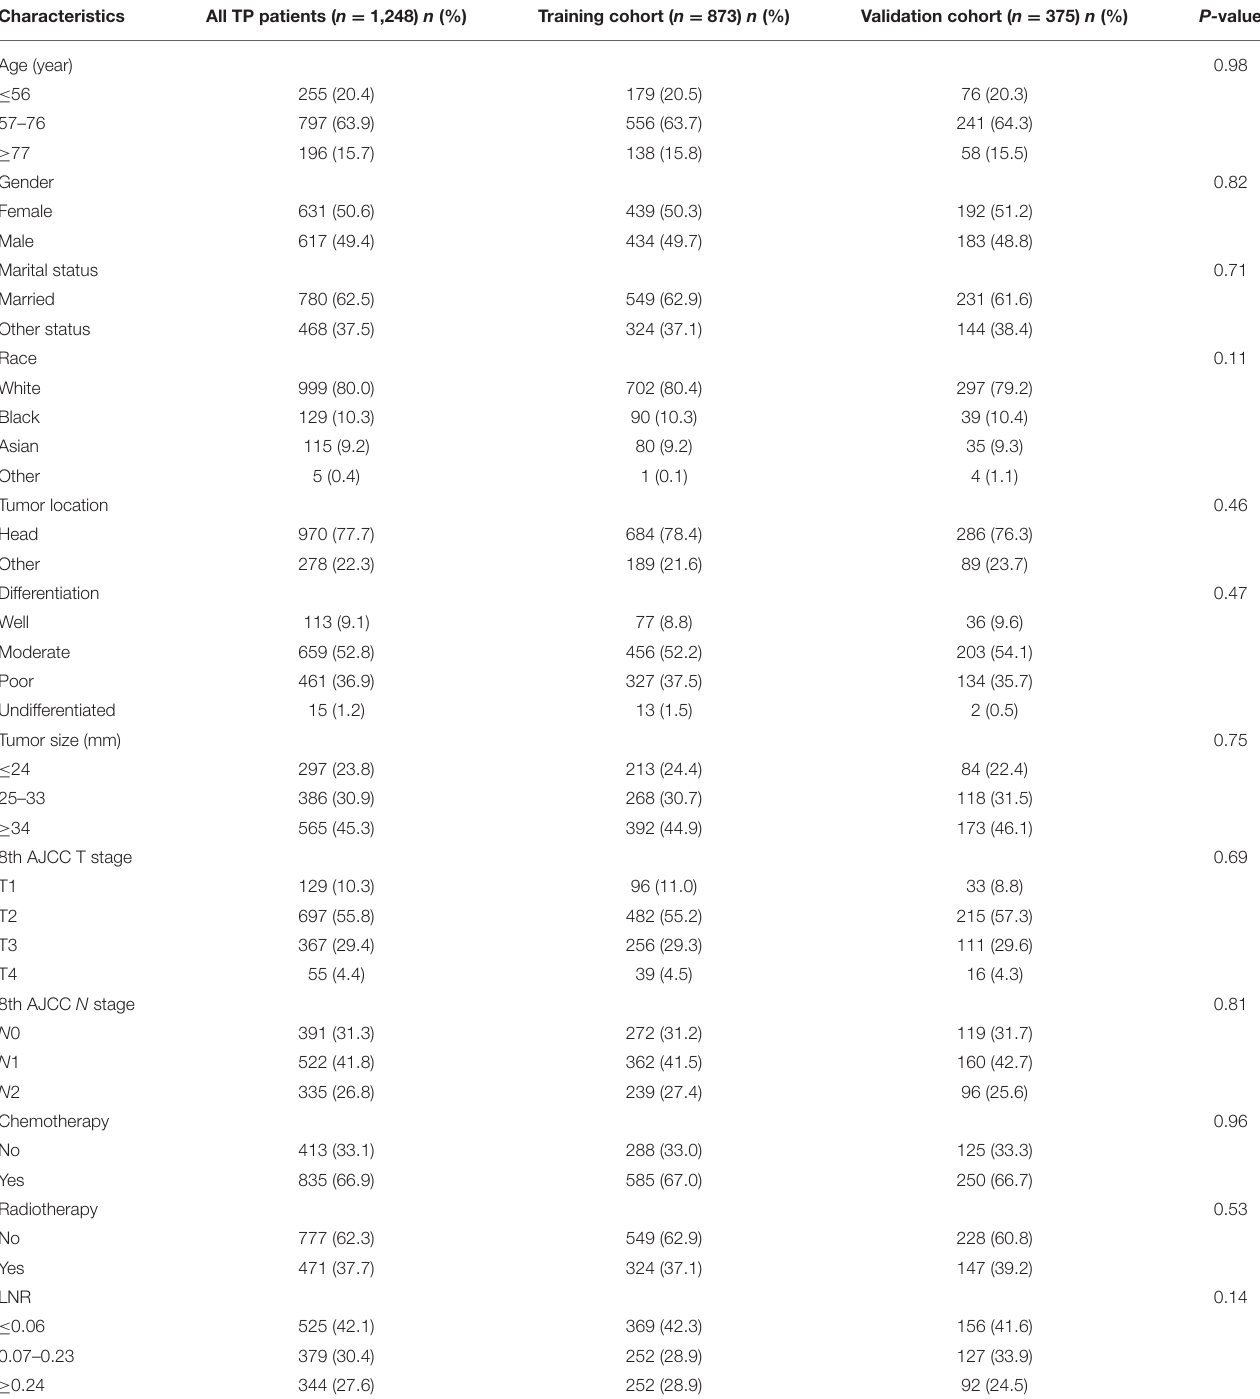
TABLE 3 | Comparison of characteristics of TP patients in the training cohort and validation cohort.